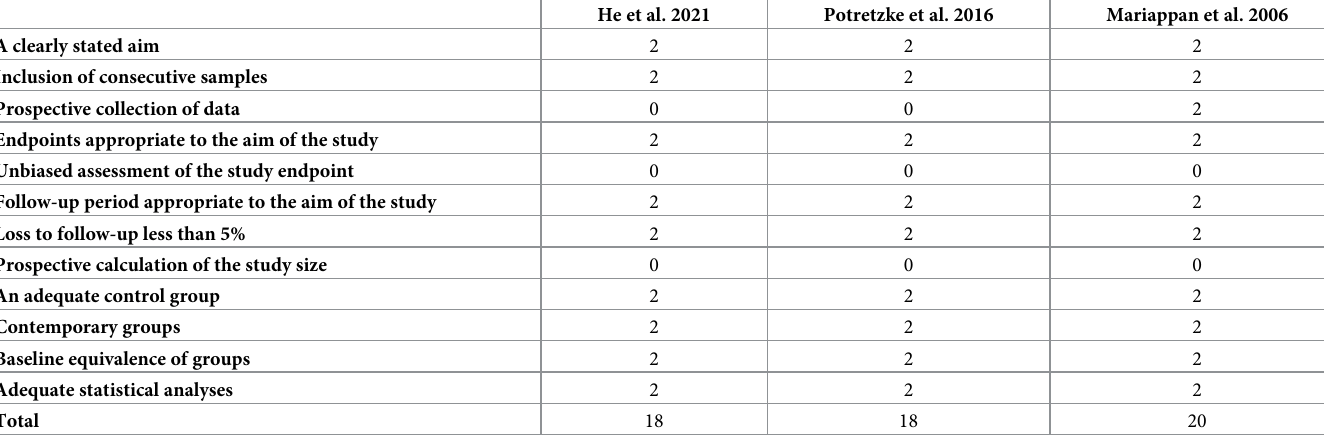
Table 2. MINORS score in non-randomized studies included in the